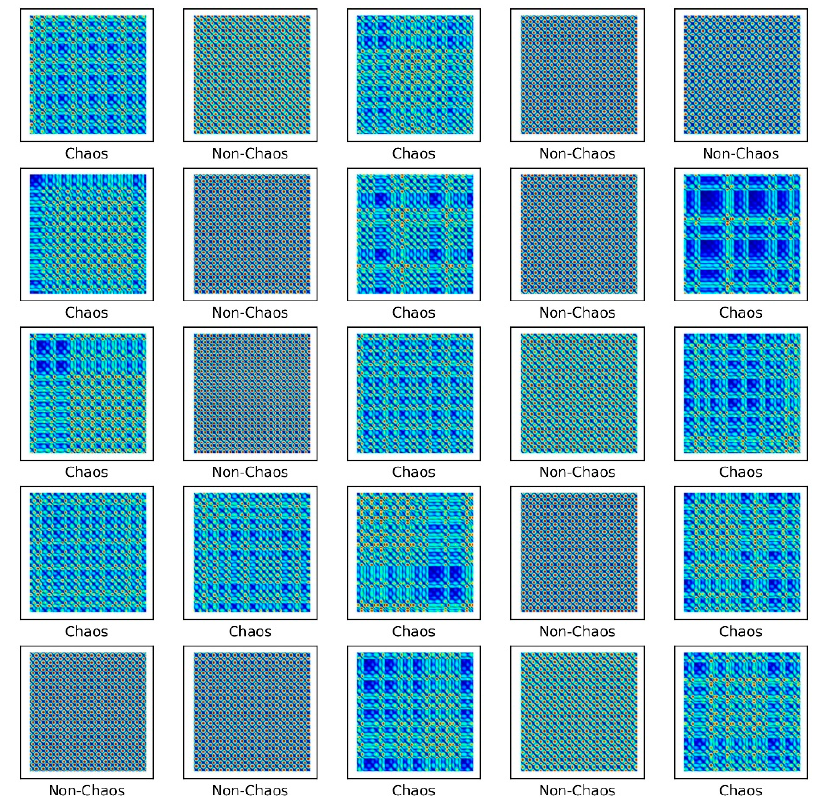
Figure 8. Unthresholded recurrence plot of the Rossler model.